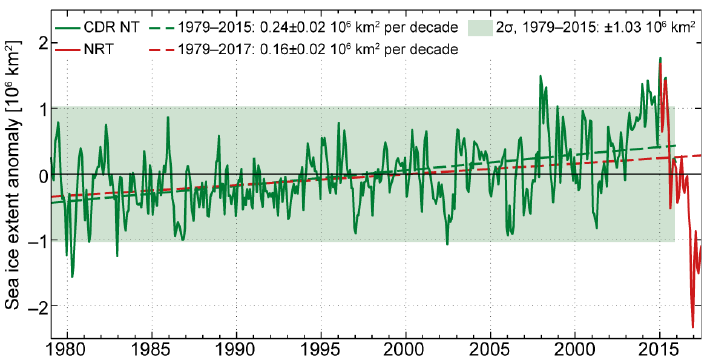
Figure 1. Monthly mean SIE anomalies since 1979 with respect to the 1979 to 2015 climatology. The period 1979 through 2015 is derived from the CDR NT data (green; Meier et al., 2013; provided by NSIDC). The period January 2015 through June 2017 is derived from the NRT data (red; Maslanik and Stroeve, 1999, updated daily; provided by NSIDC). Green shading shows the ± 2 standard deviation of the CDR NT record and the green dashed line shows the respective long-term trend derived from linear regression analysis. The red dashed line shows the long-term trend for the period 1979 through June 2017 when extending the CDR NT record using the period January 2016 through June 2017 from the NRT